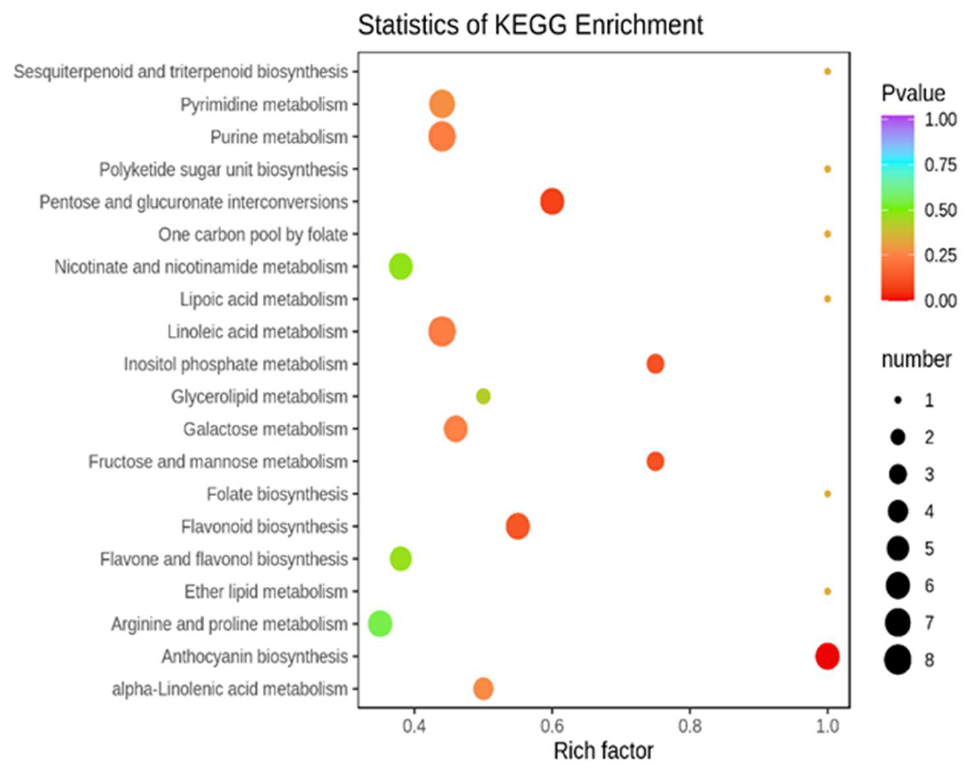
Figure 4. DAMs KEGG pathway enrichment between CK and T1.